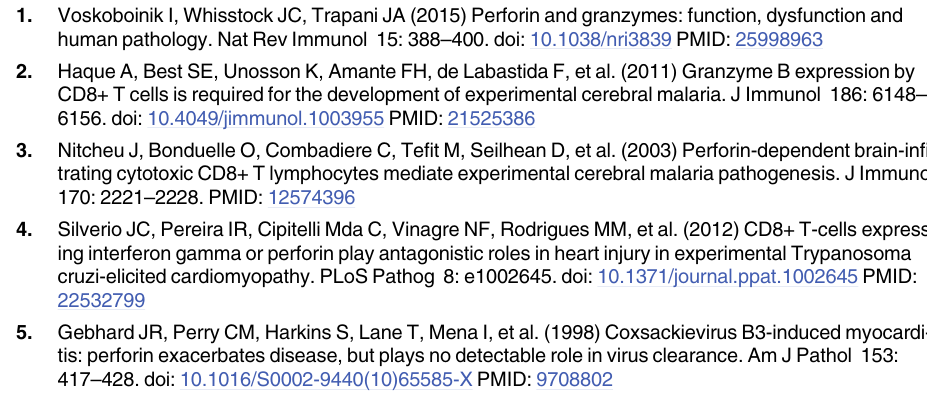
S8 Fig. Cytotoxic markers with IL1B mRNA levels in lesions from L . braziliensis infected patients. Log2 expression of (a) IL1B and (e) IL1A in normal skin and L . braziliensis patients’ lesions. Data obtained from 10 normal skin and 25 lesions. Log2 expression of GZMB and (b) IL1B or (f) IL1A , GZMA and (c) IL1B or (g) IL1A , and PRF1 and (d) IL1B or (h) IL1A in l . bra- ziliensis patients’ lesions. Data obtained from 25 skin lesions [24]. (cid:3)(cid:3) p < 0 . 01 ; (cid:3)(cid:3)(cid:3) p (cid:20) 0 . 001 .